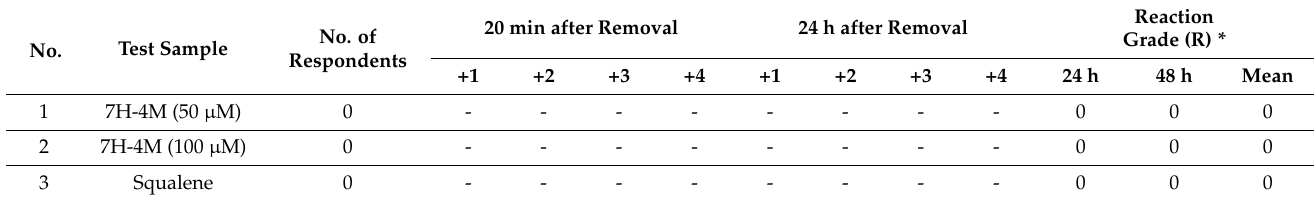
Table 1. The results from the primary human skin irritation tests ( n = 31).